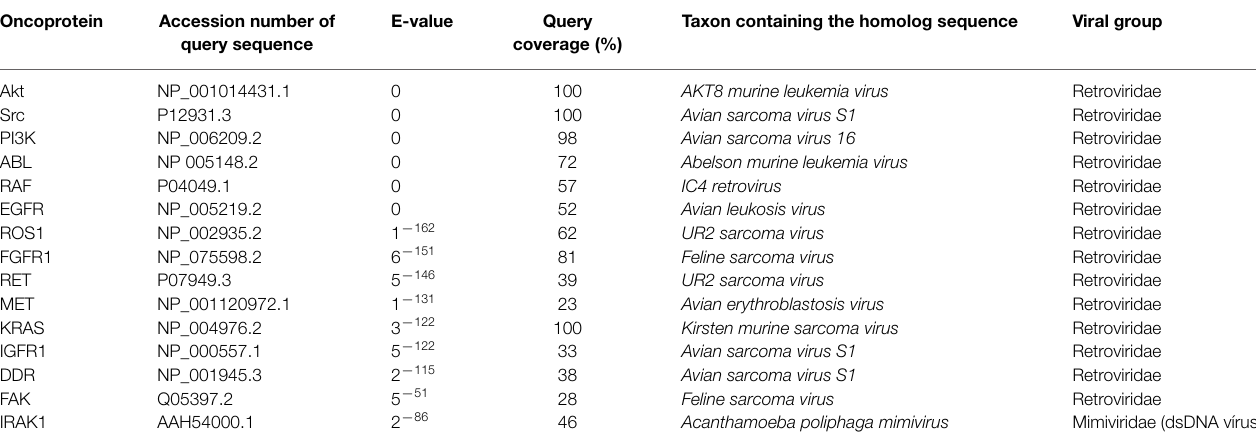
TABLE 1 | Viral homologies found in human oncoproteins.